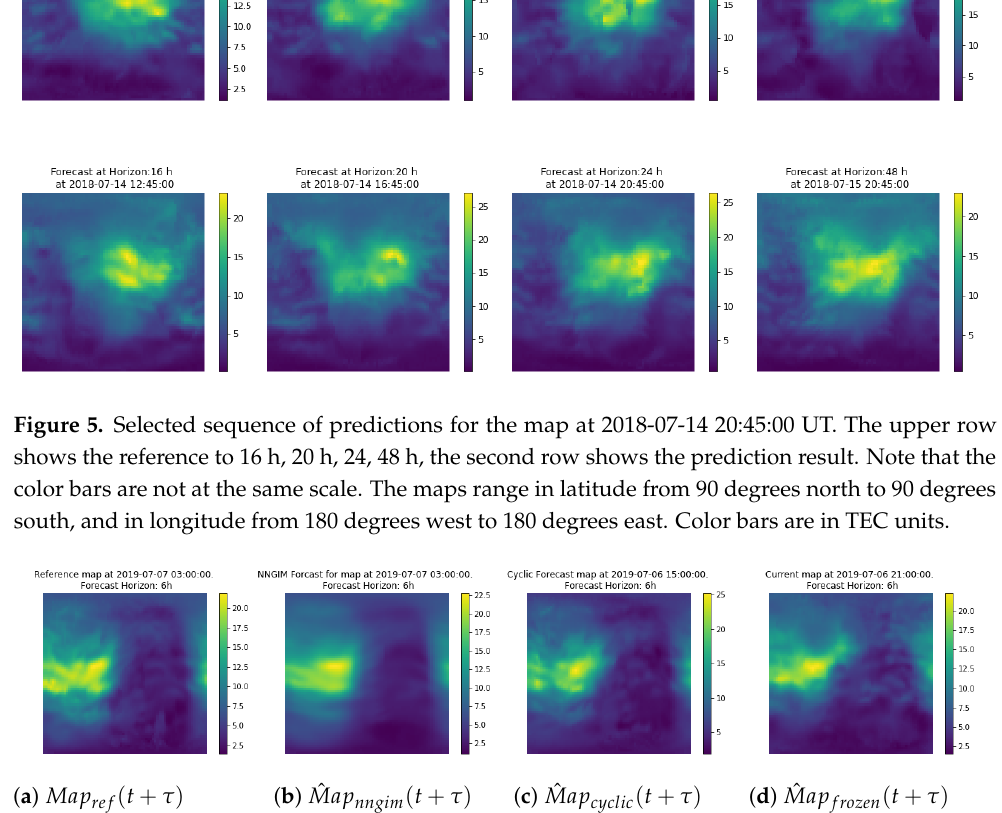
Figure 6. Comparison of the reference map ( a ) at 2019-07-07 03:00:00 UTC , with the NNGIM pre- diction, ( b ), with the cyclic prediction, ( c ) and with the frozen prediction (i.e., using current map) ( d ) with the frozen map. Note that the maps are in the original coordinates, not in the sun-fixed geomagnetic